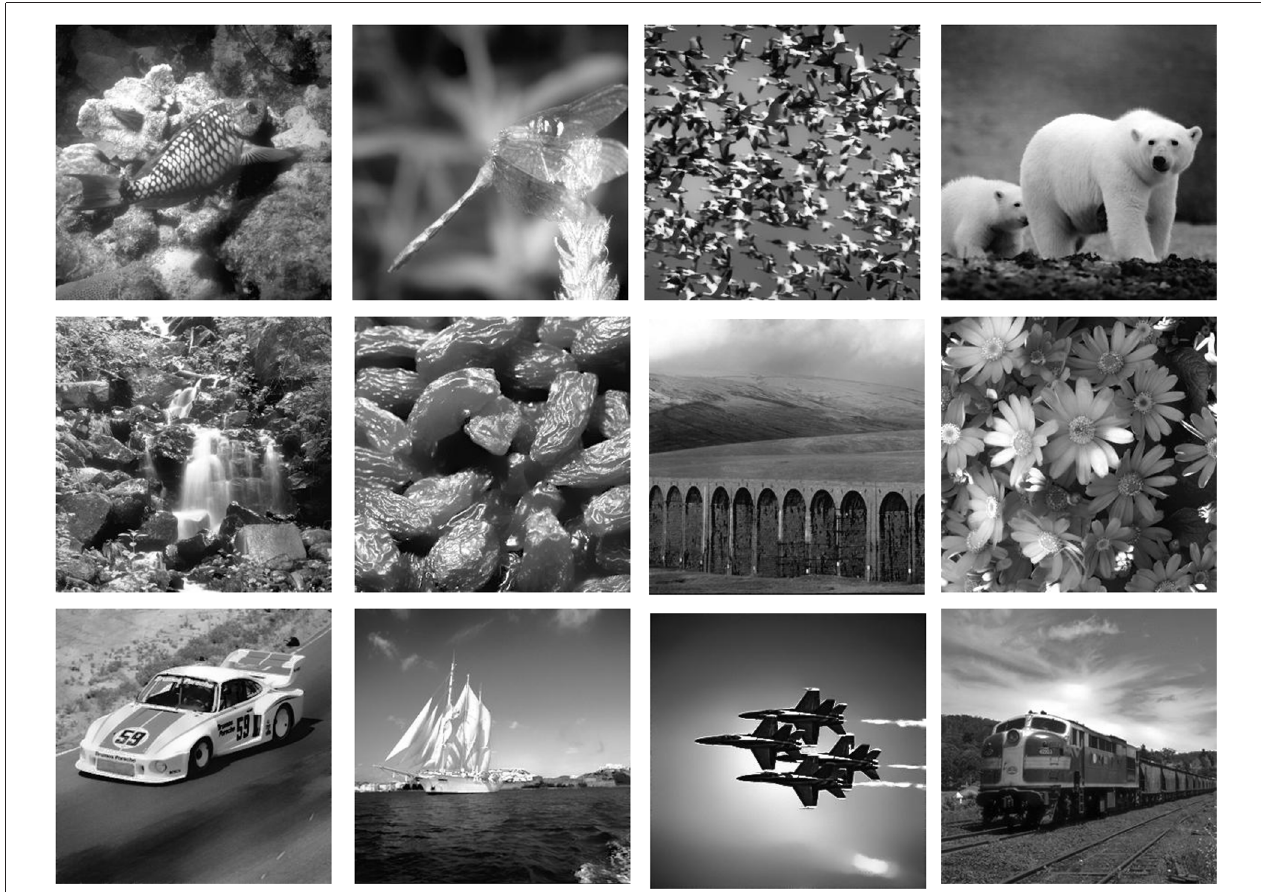
FIGURE 1 | Sample images of animal (top), non-animal (middle) and vehicle (bottom)